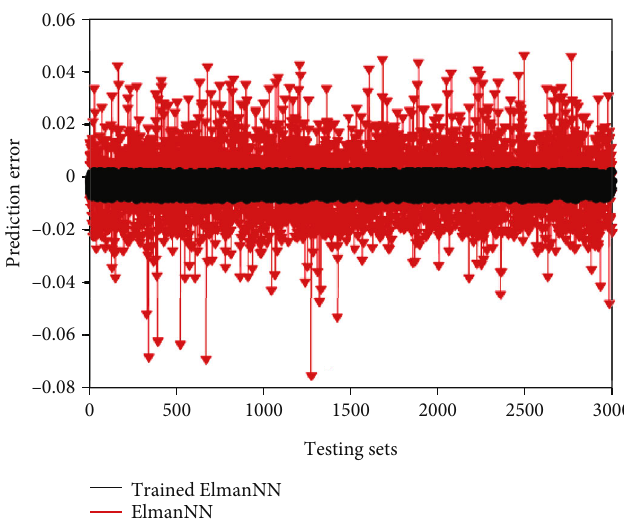
Figure 10: The prediction error of conventional and trained ElmanNN.